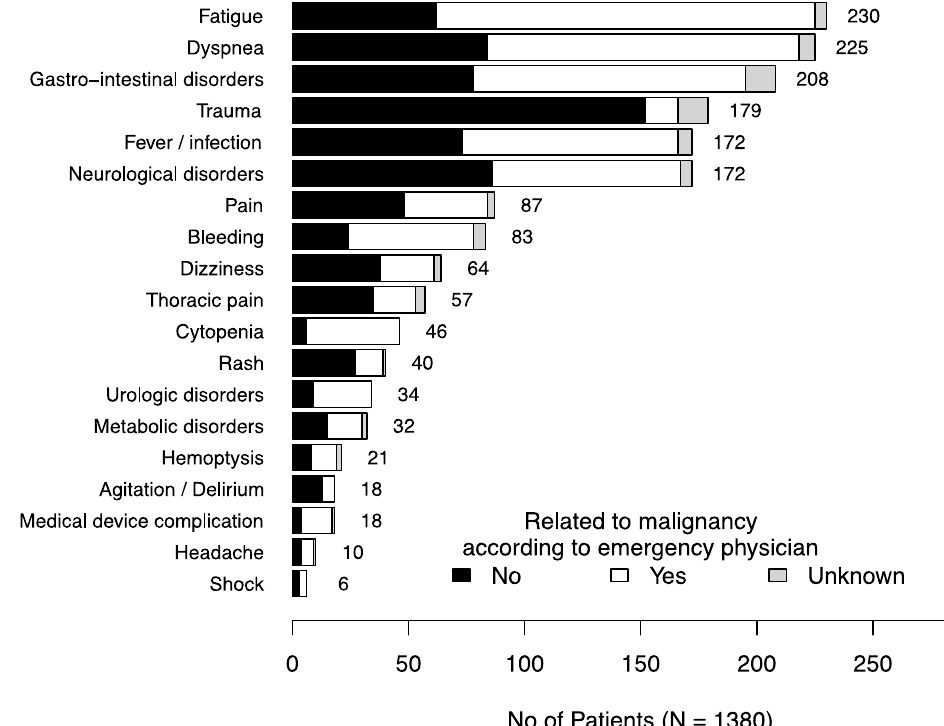
Figure 2. Reasons for cancer patients’ attendance to emergency departments.